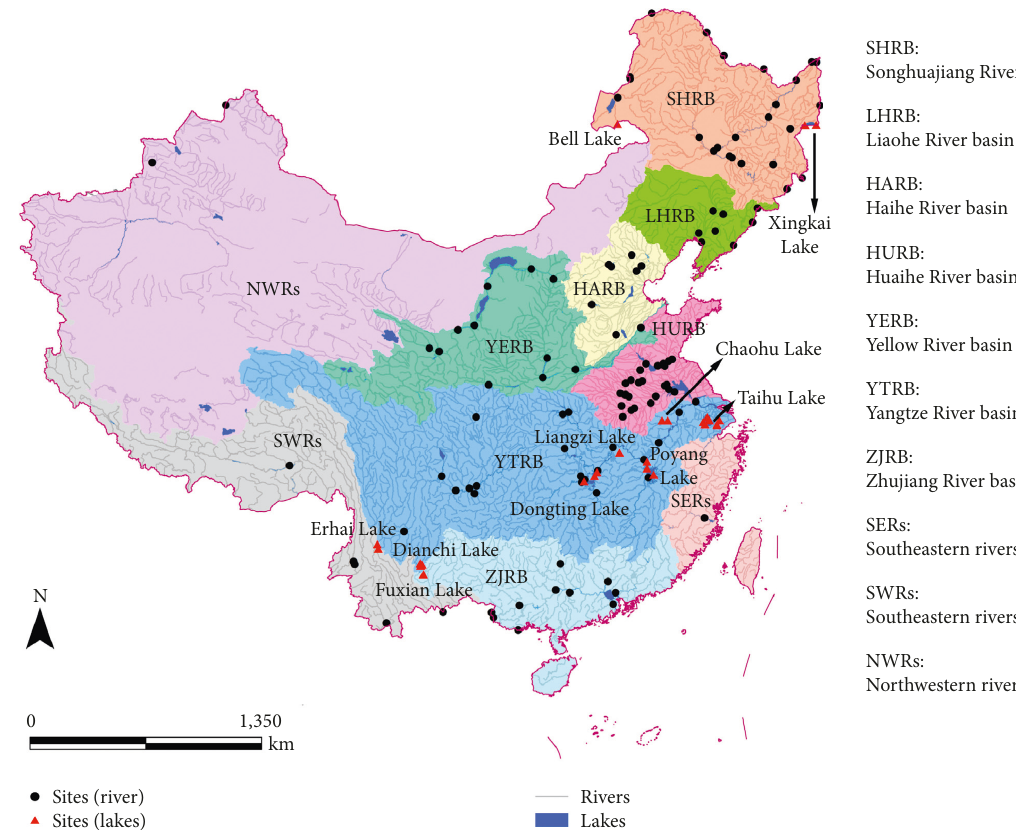
Figure 1: Location of national monitoring sites in Chinese surface freshwaters (ten rivers and ten